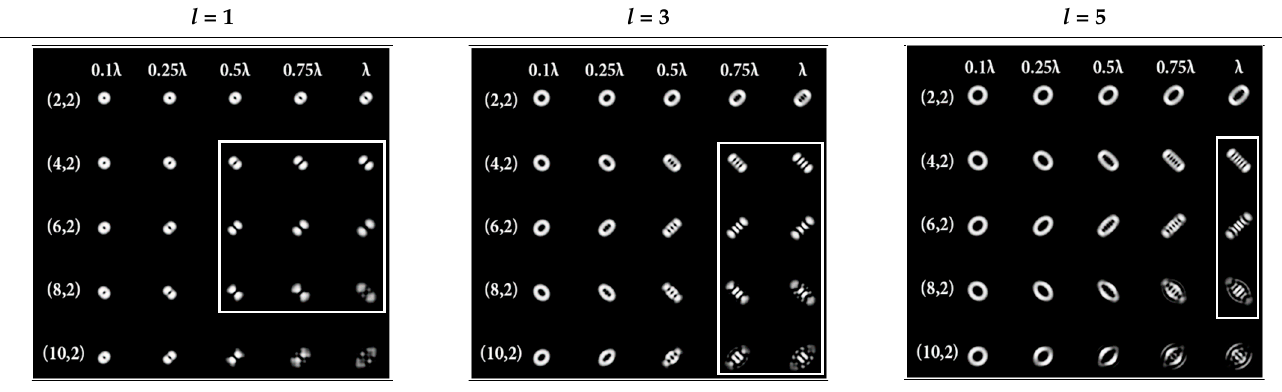
( , ) Z r ϕ ( n = 2, 4, 6, 8, 10) with various levels ,2 n